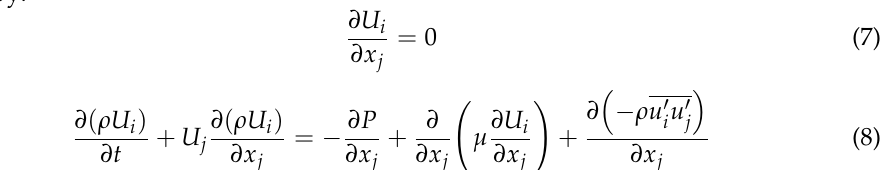
Table 2. LCT test conditions for cavitating flow